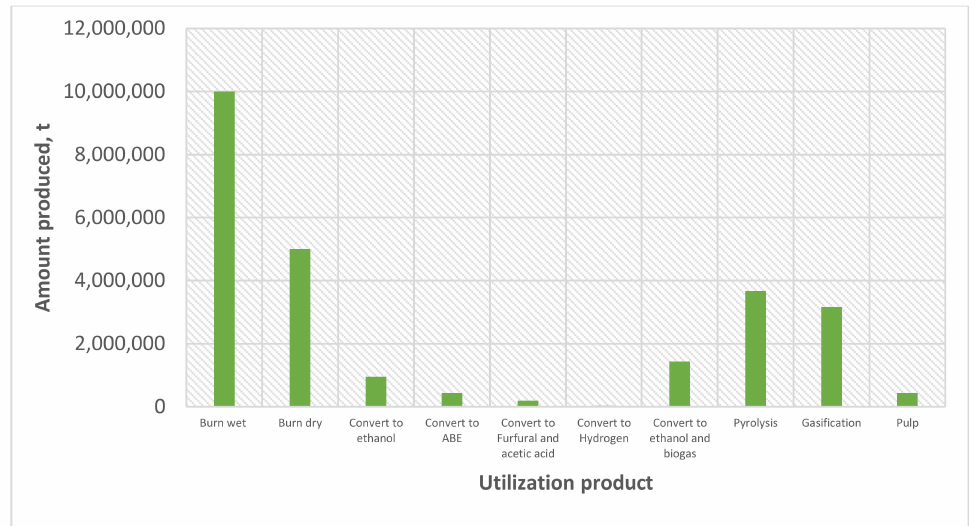
Figure 6. Amount of the products from different utilisation processes of bagasse, the leftover solid was not considered in the calculation.